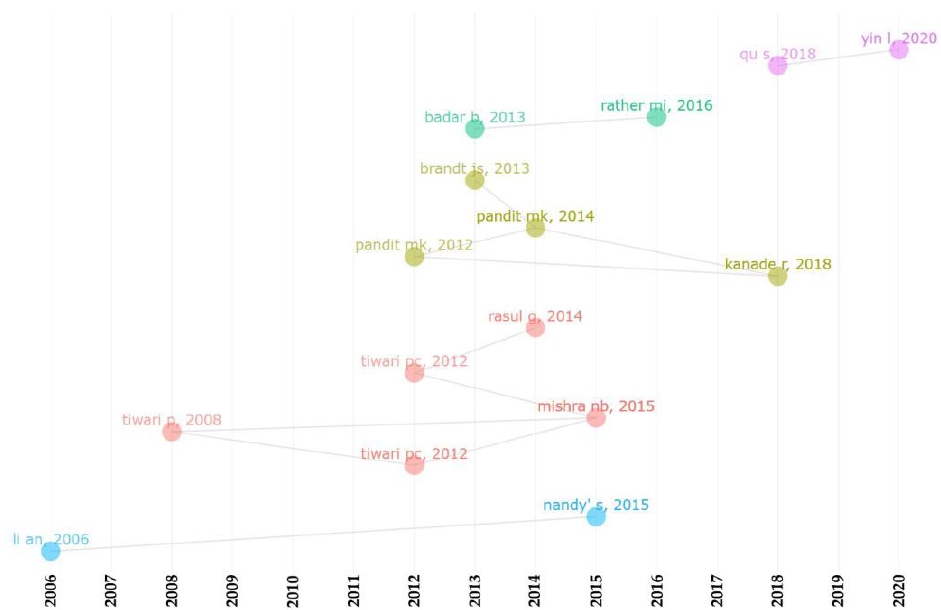
Figure 9. Historical direct citation network of top-cited papers considering the ecological and environmental effects of land use and cover changes (LUCC) on the Qinghai – Tibetan Plateau (QTP).